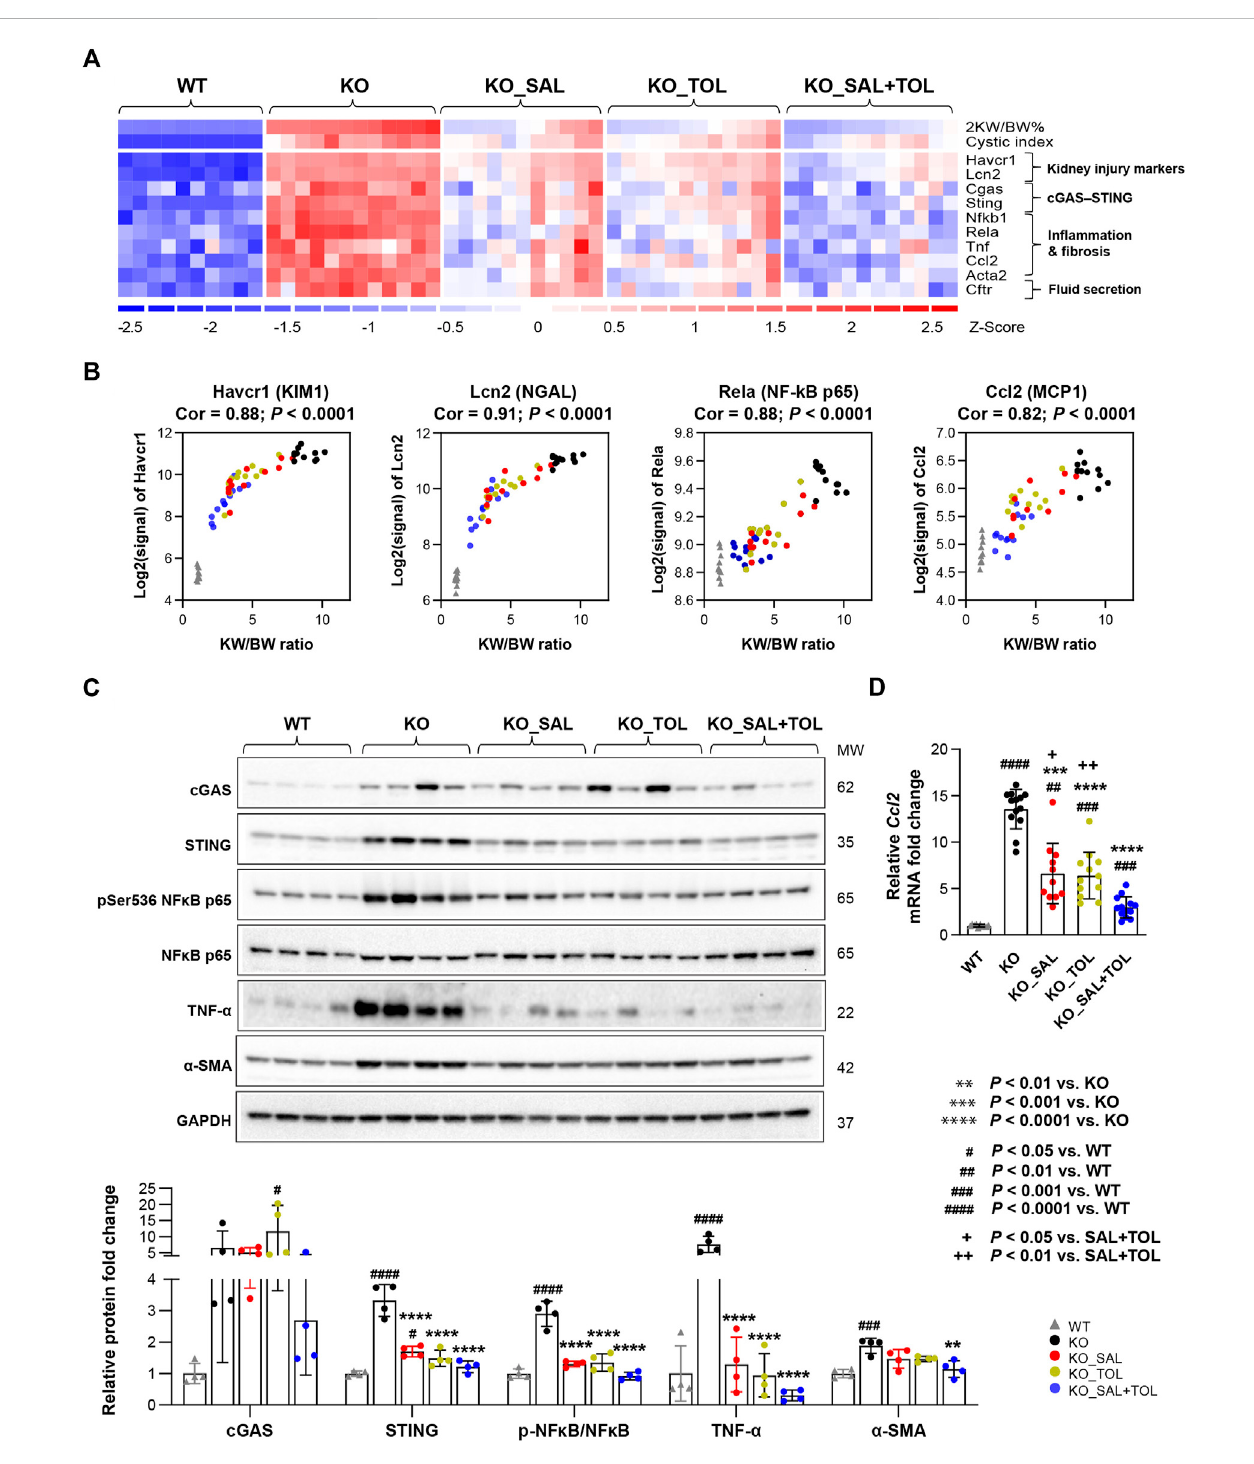
FIGURE 3 Thecombinedtreatmentattenuatedexpressionofkidneyinjury,in fl ammation,and fi brosismarkersin Pkd1 mutantmousekidneys. (A) Heatmapshowed theincreasedmRNAexpressionforkidneyinjurymarkers( Havcr1 , Lcn2 ),componentsofcytosolicDNAsensor( Cgas , Sting ),in fl ammatorytranscriptionfactor NF κ B subunits ( Nfkb1 , Rela ), in fl ammatory cytokines ( Tnf , Ccl2 ), fi brosis marker ( Acta2 ), as well as chloride channel ( Cftr ) in Pkd1 mutant kidneys; all these changes were attenuated by the treatments. (B) Transcript levels (microarray) of Havcr1 , Lcn2 , Rela , and Ccl2 correlated with 2 KW/BW% in Pkd1 mutant kidneys. (C) Relative protein levels ofcGAS, STING, NF κ B activity (pSer536 NF-kB p65),TNF- α , and α -SMA (Acta2) inWT, untreated and treated mutant mouse kidneys by Western blot. GAPDH was used as a loading control. (D) Relative mRNA levels of Ccl2 in WT, untreated and treated mutant mouse kidneys by RT-